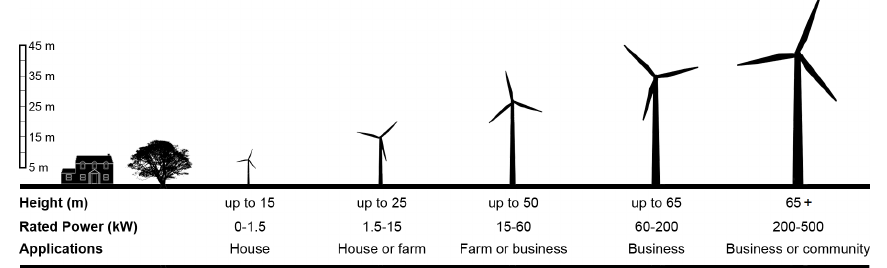
Figure 1. Small and distributed wind turbine dimensions and rated power outputs as a function of various applications.